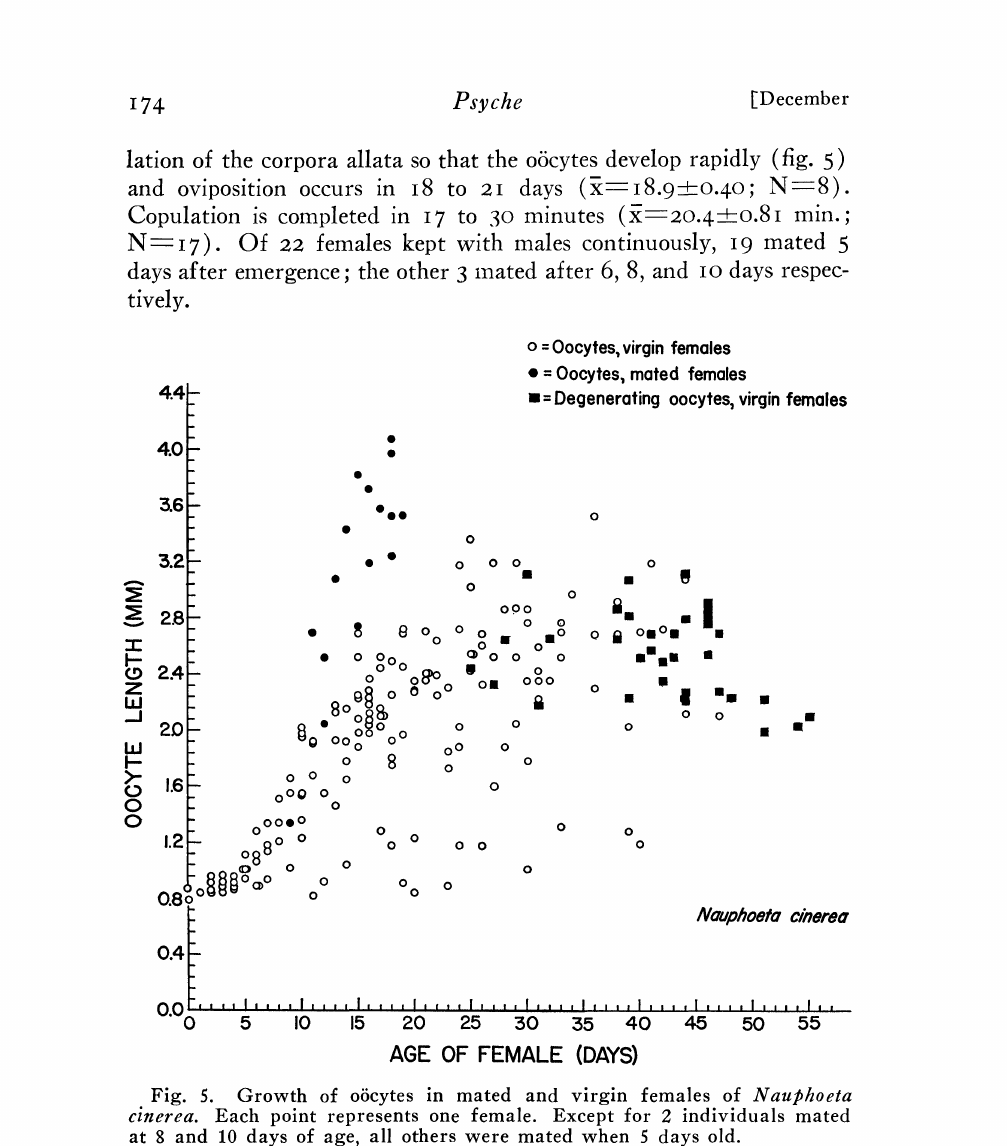
Fig. 5. Growth of o6cytes in mated and virgin females of Nau#hoeta cinerea. Each point represents one female. Except for 2 individuals mated at 8 and 10 days of age, all others were mated when days